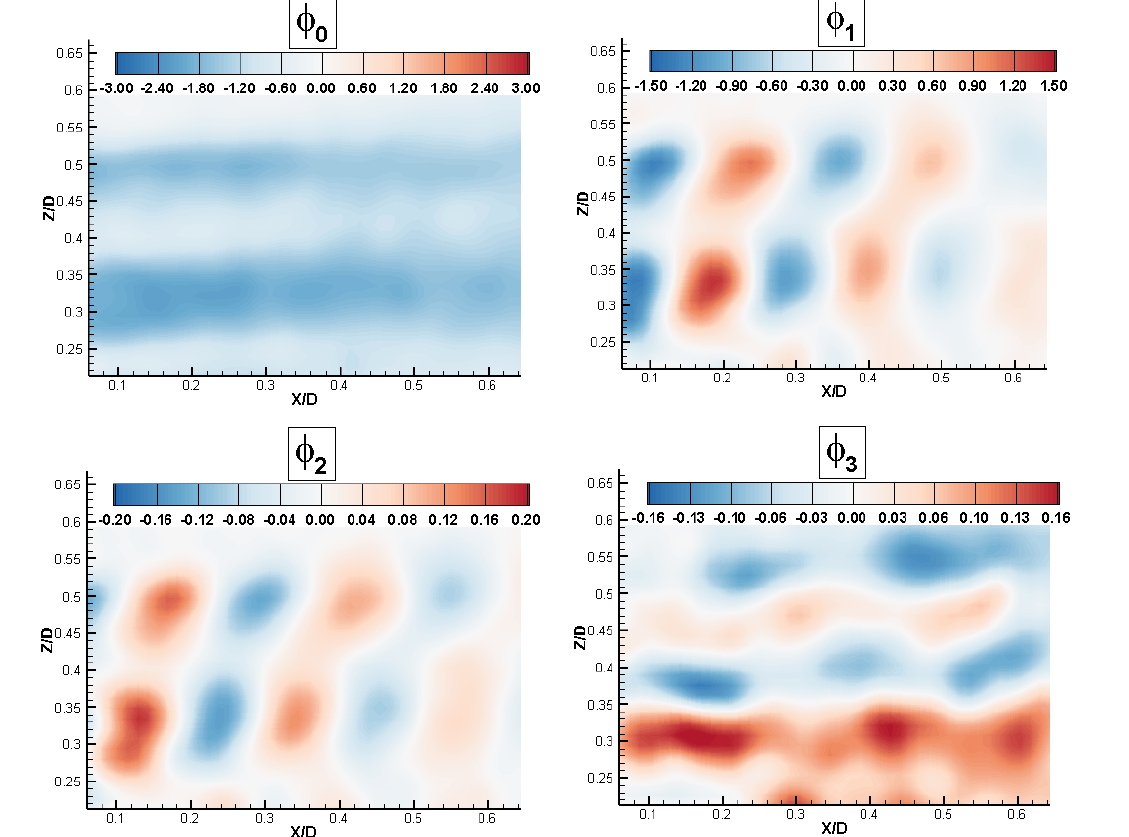
Figure 11. Normalized vorticity contours of vorticity-based POD mode shapes for R1